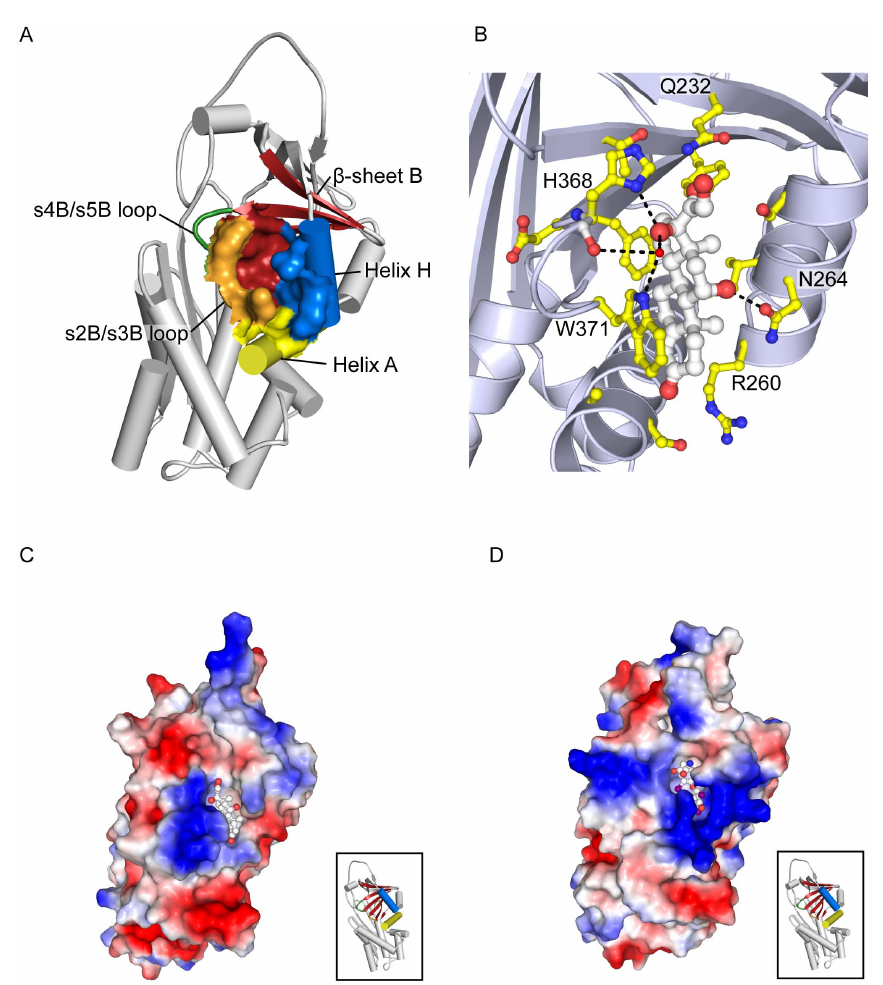
Figure 3. Ligand binding pocket of the hormone binding globulins. (A) The ligand binding pocket (solid surface, PDB entry 2VDY [19]) is formed by Helix A (yellow), Helix D (blue), b -sheet B (red), the s2B/s3B loop (orange) and the s4B/s5B loop (green). (B) R-state human CBG (PDB 2VDY [19], chain A) showing the interactions of pocket residues with cortisol. (C) Corticosteroid binding globulin (PDB 2VDY, chain A), and (D) Thyroxine binding globulin (PDB 2CEO [54], chain A). Electrostatic map: negative potential (red); positive potential (blue), uncharged/hydrophobic (white). (C) and (D) (inset) . Orientation represented in the electrostatic maps, with the key secondary structural elements coloured as in (A)